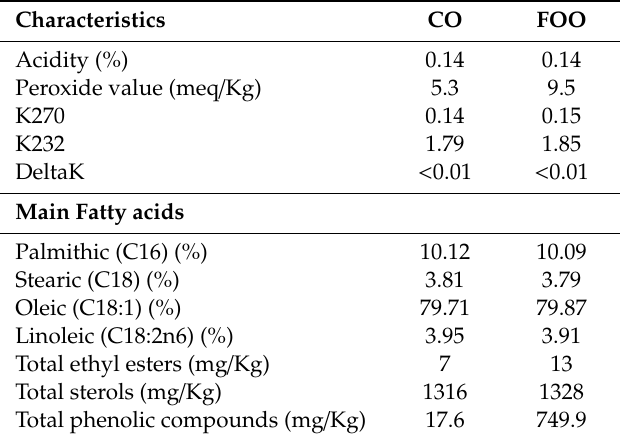
Table 1. Characteristics of the olive oils used in the